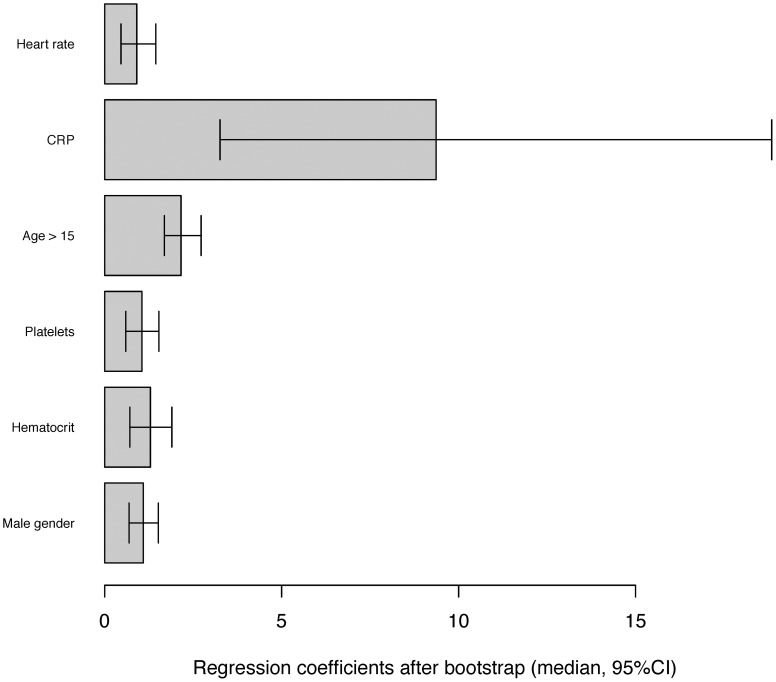
Representation of the beta coefficients from bootstrap resampling of clinical and biological variables.